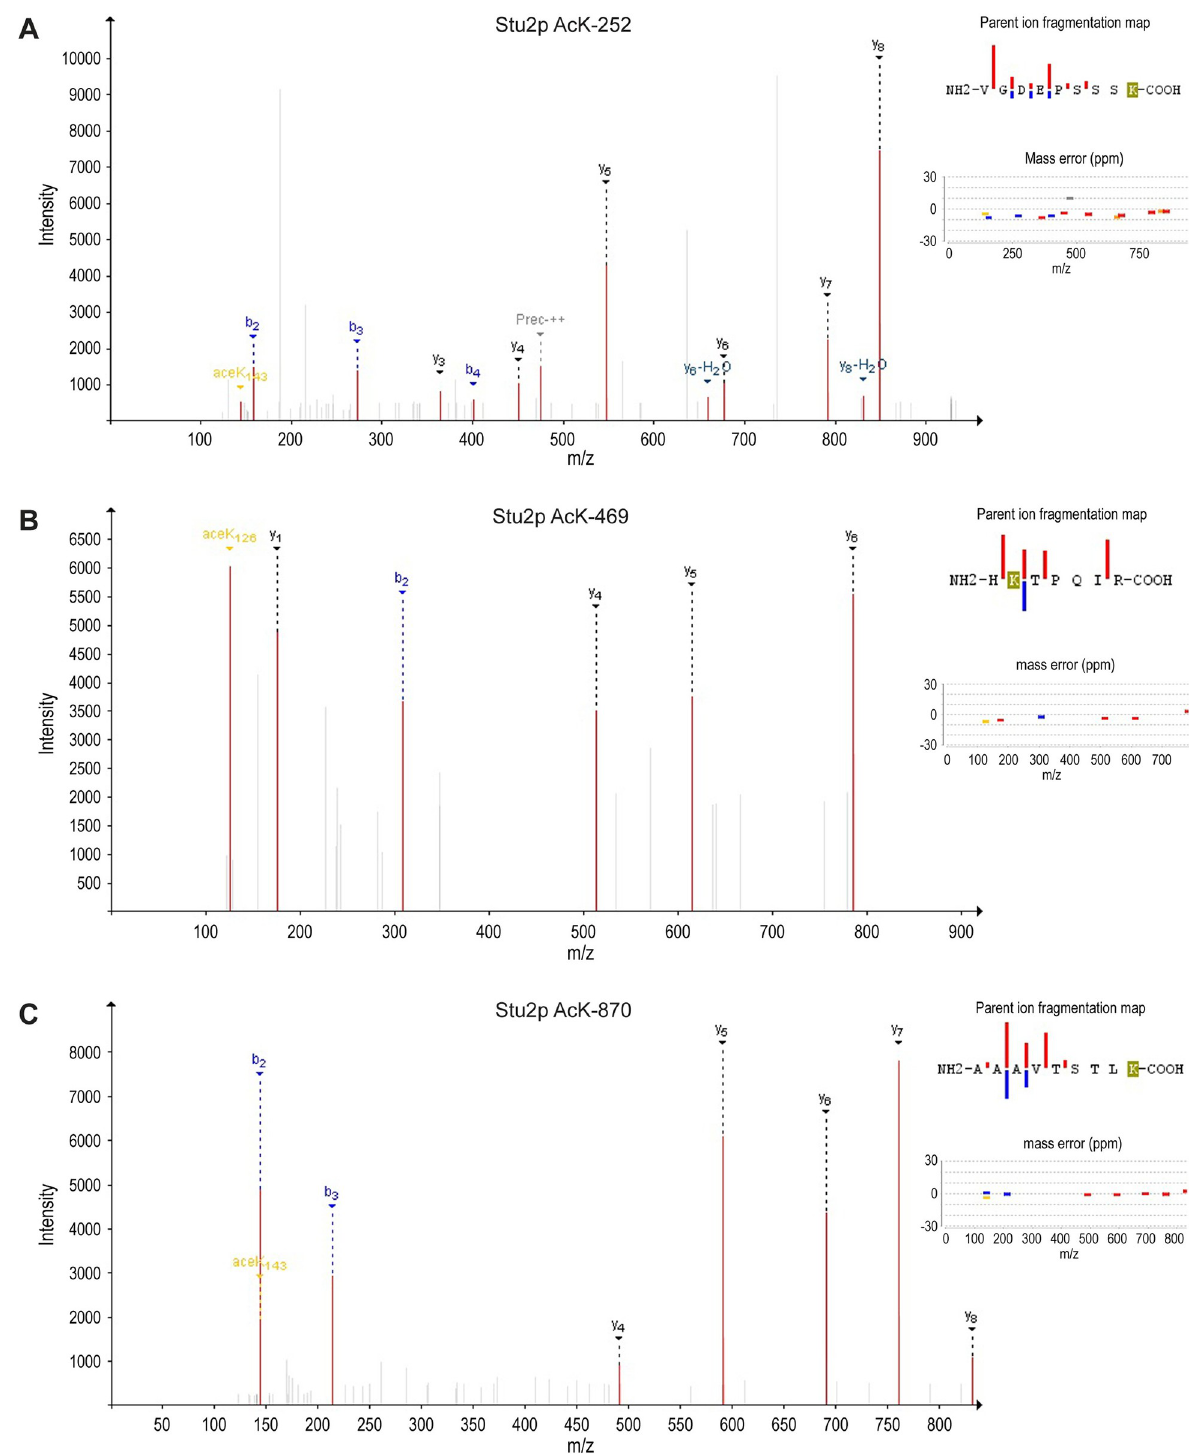
Fig 2. Tandem mass spectrometry identified three acetylated lysines residues. (A) K252, (B) K469, and (C) K870. Parent ion fragmentation maps and mass error graphs are presented adjacent to each mass spectra to support peptide ID identification. Mass spectra were analyzed by the six search engines; Comet, MS Amanda, MS-GF+, Myri-Match, OMSSA, and X!Tandem, using SearchGUI. SearchGUI outputs were then combined using PeptideShaker for interpretation, statistical analysis, and viewing. For the spectra shown, mass deviations of 2.19 ppm (C), 0.53 ppm (D) and 0.47 ppm (E) were observed. For each site, all six search engines identified these three lysines as the most probable acetylated peptide.